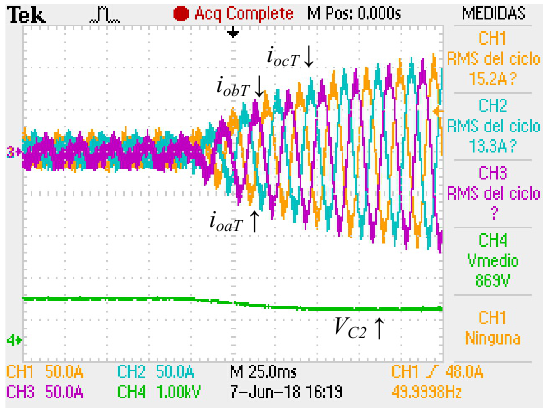
Figure 16. VSC o currents and V C 2 .